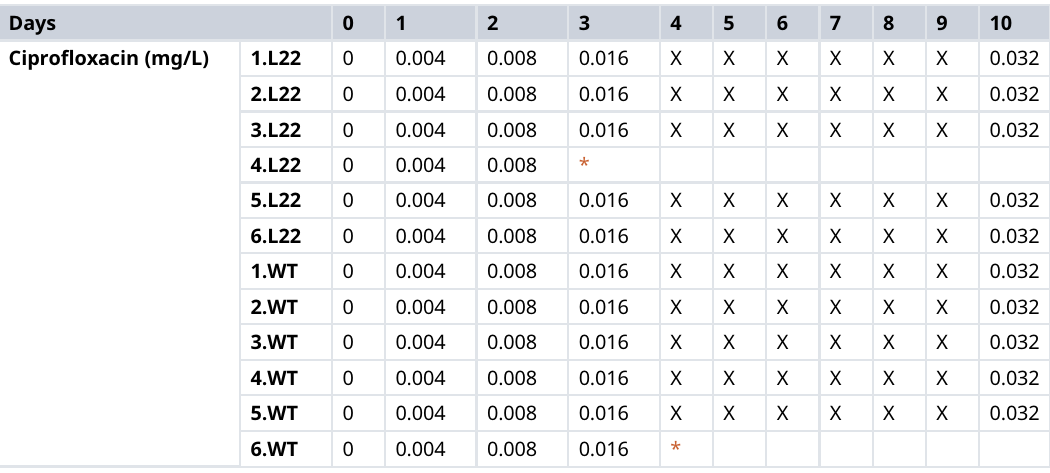
Table 2. Progression two lineages, WHO-F WT (n=6) and WHO-F L22mut (n=6), of MIC evolution over the days when exposed to increasing amounts of CIP. (mut= mutation; MIC: Minimum inhibitory concentration; CIP: